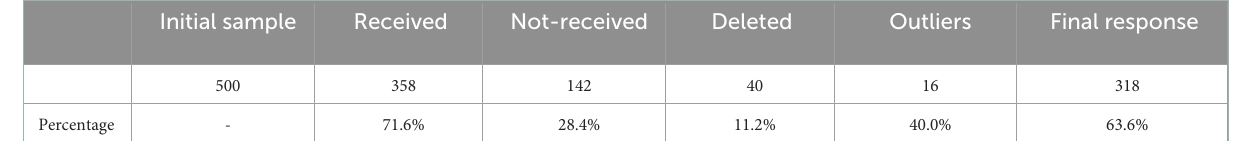
TABLE 1 Data cleaning summary.